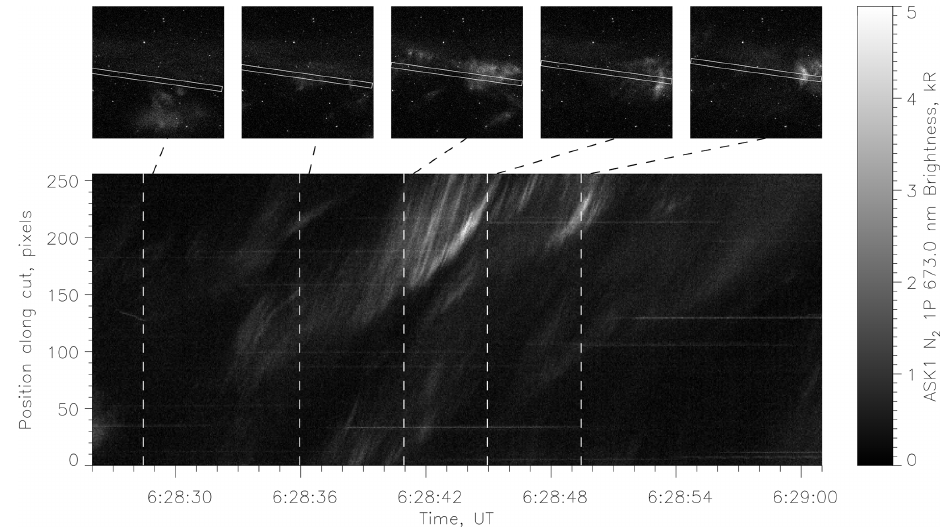
Figure 10. ASK1 (N 2 1P) keogram made using a moving cut to track the FAEs in event 2b. White dashed lines mark the times of the images shown above the keogram. The white boxes indicated in the images show the location of the keogram cut.